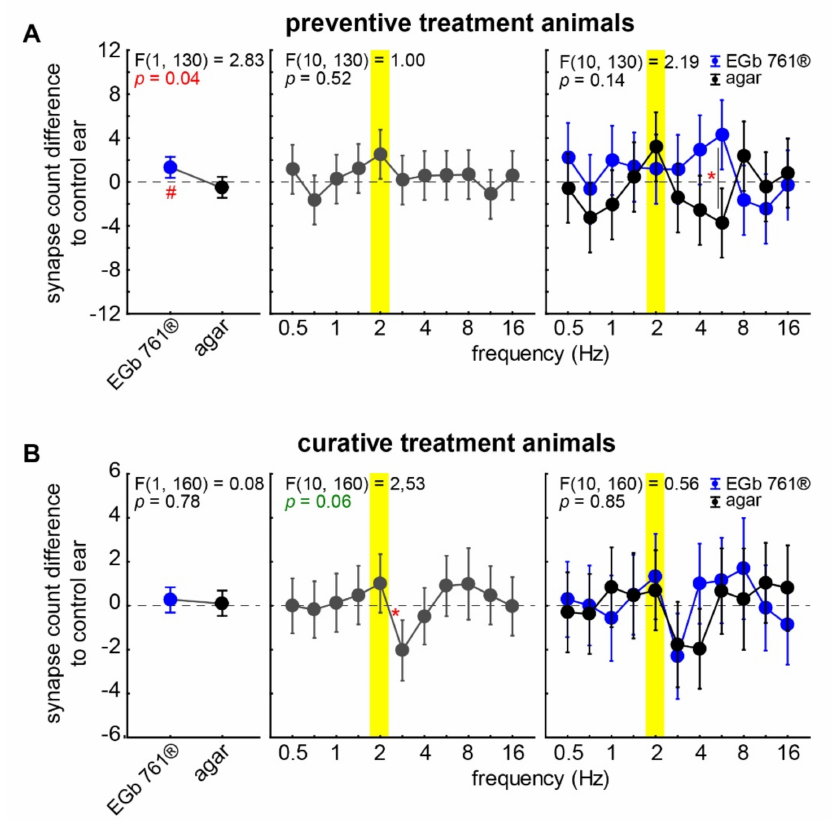
Figure 6. Synapse count differences of trauma and control ear (negative values show a loss of synapses) 3 weeks after trauma. ( A ) Results of the two-factorial ANOVA of the synapse difference with the factors frequency and application group in the preventive treatment animal group. The left and center panels give the one-factorial analyses, and the right panel depicts the interaction of both factors. The yellow bar marks the trauma frequency. Symbols depict the mean values and 95% confidence intervals of EGb 761 ® (blue) and agar control groups (black). The F-statistic is given in the panels, where red asterisks mark significant Tukey post hoc tests (* p < 0.05). A red # symbol marks a significant difference from zero in the single sample t -test (# p < 0.05). ( B ) Results of the two-factorial ANOVA of synapse difference in the curative treatment animal